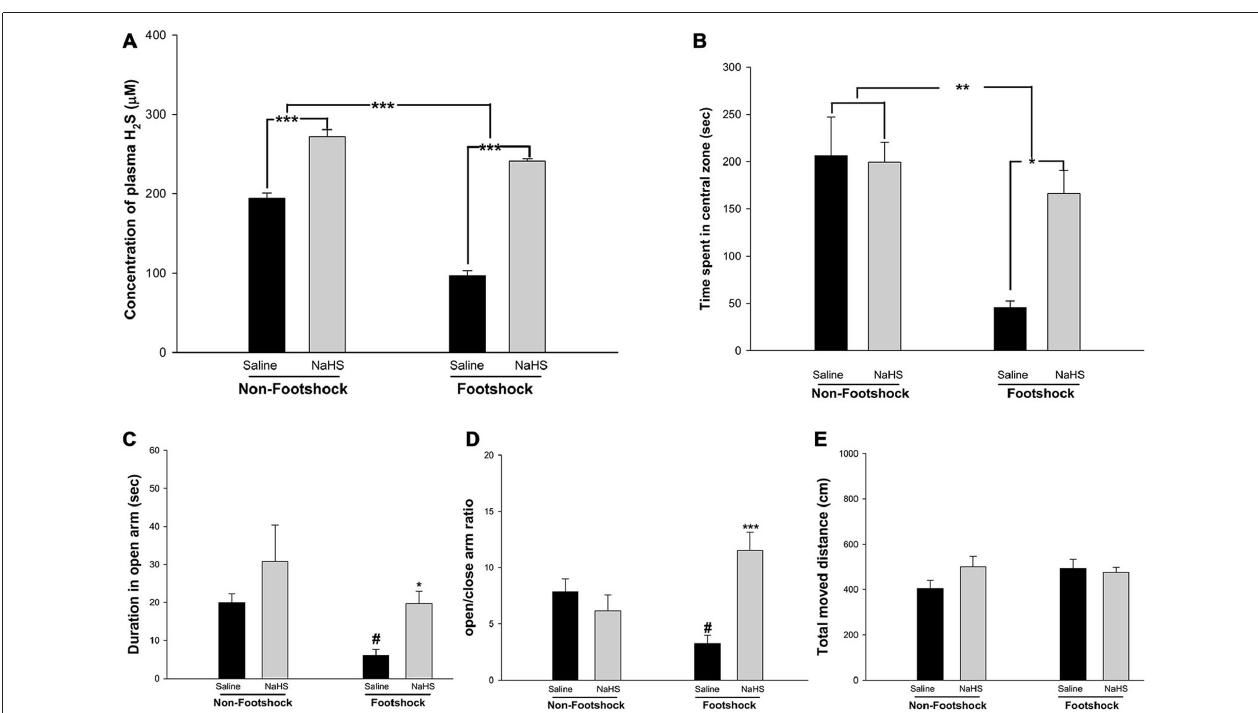
FIGURE 3 | The effects of NaHS treatment on plasma H 2 S levels and anxiety. (A) H 2 S concentrations were measured in mouse plasma collected after the MWM. H 2 S levels were reduced in the footshock-stimulated animals, and NaHS treatment recovered the H 2 S levels. (B) Time spent in the central zone during the OF test. The animals in the footshock/NaHS group spent more time in the central zone than those in the footshock/saline group. The data are the mean ± SEM of each group ( n = 15 per group). ∗ p < 0.05; ∗∗ p < 0.01; ∗∗∗ p < 0.001. (C,D) Duration in the open arms and the open/enclosed arm ratio for the four groups. The duration in the open arm and the open/enclosed arm ratio were greater in the footshock/NaHS group than in the footshock/saline group. (E) Total distance traveled in the EPM. During the period of the EPM task, the total moved traveled did not differ between any of the groups of mice. Data are mean ± SEM of each group ( n = 15 per group). # p < 0.05, compared to the non-footshock/saline group. ∗ p < 0.05 and ∗∗∗ p < 0.001, compared to the footshock/saline group.